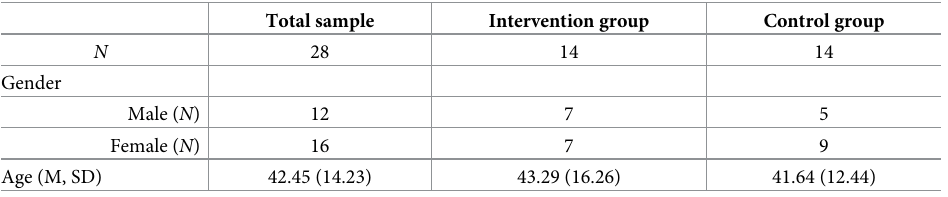
Table 2. Demographic data of the total study sample and each group.